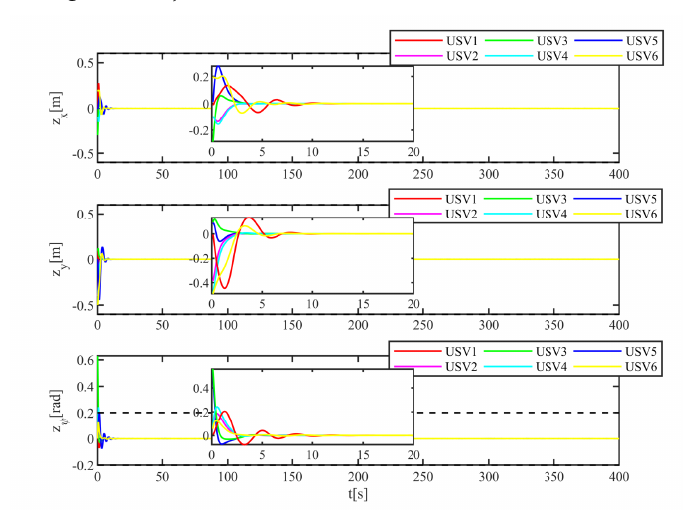
Figure 4. Trajectories of six USVs.